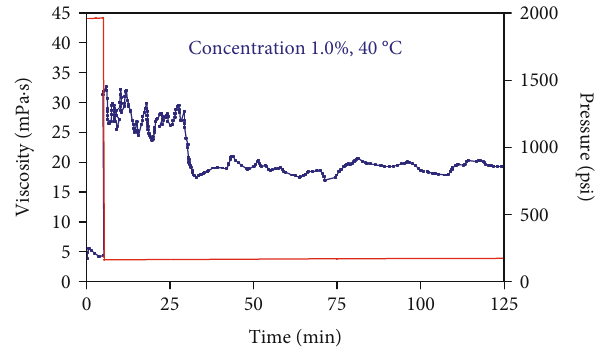
Figure 3: Curve of viscosity versus shear time at a thickener concentration of viscosity. 2